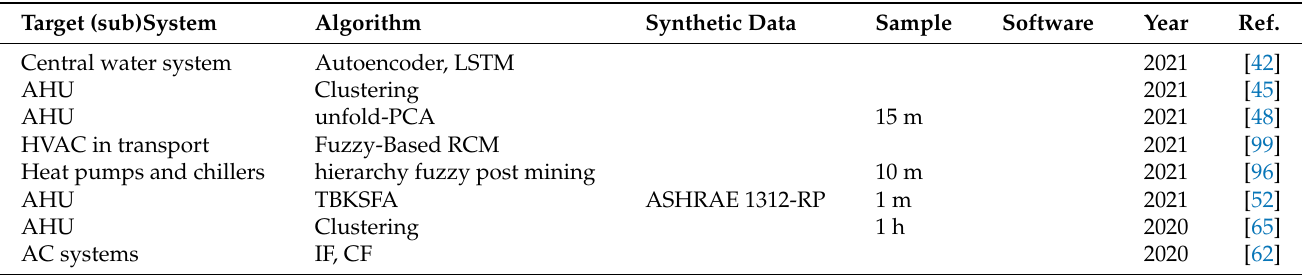
Table 5. Unsupervised learning used in the research from the selected literature. For clarity, all acronyms are provided in the Abbreviations